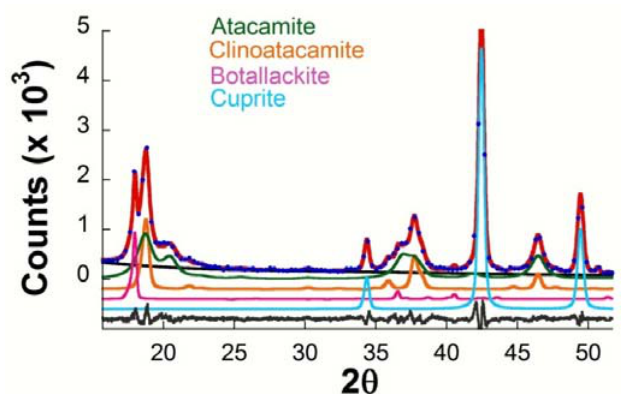
Figure 4. Typical representation for comparison of observed (blue circles) and calculated (solid red line) XRD patterns obtained after Rietveld refinement for patinas formed on copper in the marine atmosphere of Cabo Vilano. The differences between experimental data and the fitted simulated pattern are plotted as a continuous grey line at the bottom, and the contribution of the component phases in different colors.